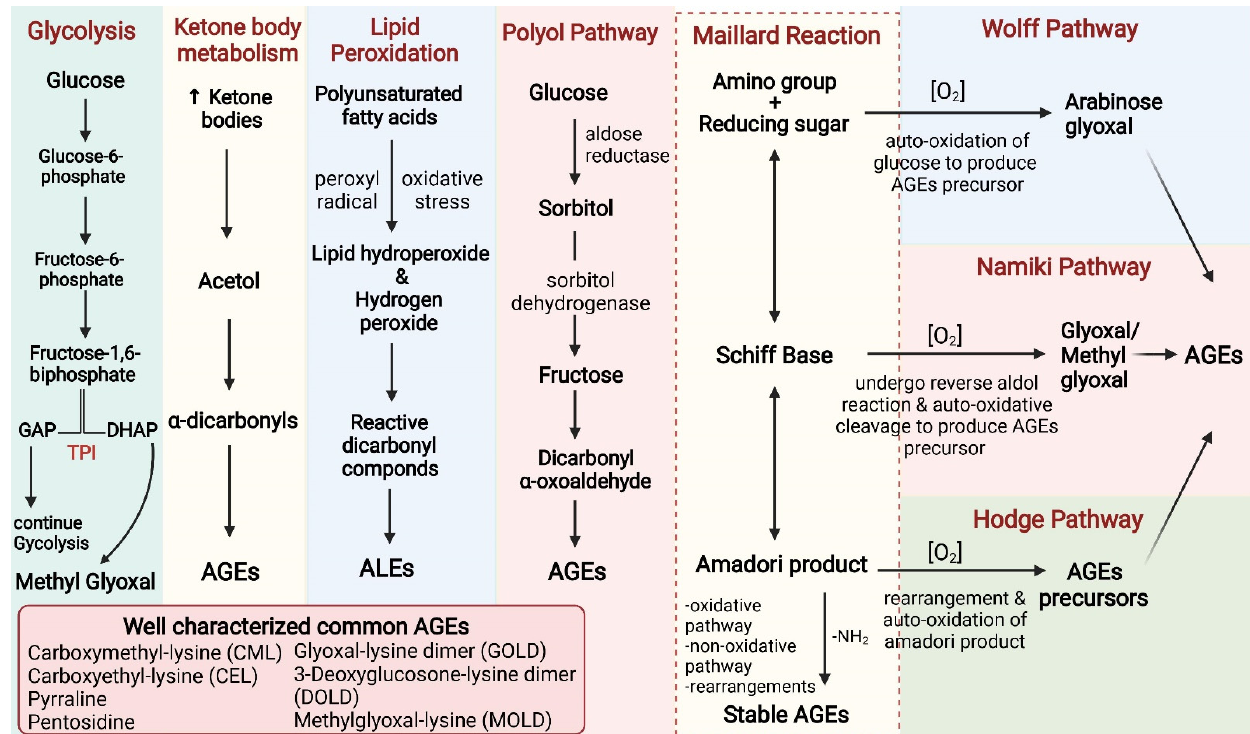
Figure 1. Pathways of AGEs formation. Maillard reaction is the classical pathway of advanced glycation end products (AGEs) formation. Metal catalyzed autooxidation of glucose (Wolff pathway) or reverse aldol reaction and autooxidation of the Schiff base (Namiki pathway) or non-oxidative Amadori product cleavage (Hodge pathway) forms reactive dicarbonyls and AGEs precursors that contribute significantly to AGEs formation. In the Polyol pathway, an excessive amount of glucose is reduced to sorbitol by the enzyme aldol reductase, which is then converted to fructose by sorbitol dehydrogenase. Fructose and its metabolites, being potent glycating agents, lead to the production of AGEs. The lipid peroxidation of polyunsaturated fatty acids leads to the formation of lipid peroxides, which first converts to reactive dicarbonyls and ultimately results in the formation of advanced lipid peroxidation end products (ALEs). The amino acid derived ketone body metabolism also generates AGEs by producing the intermediate AGEs precursor reactive dicarbonyls. The endogenous generation of methylglyoxal via the triose phosphate isomerase reaction of glycolysis is also an important source of AGEs. Some of the important reactive dicarbonyls involved in AGEs formation include methylglyoxal, glyoxal, and